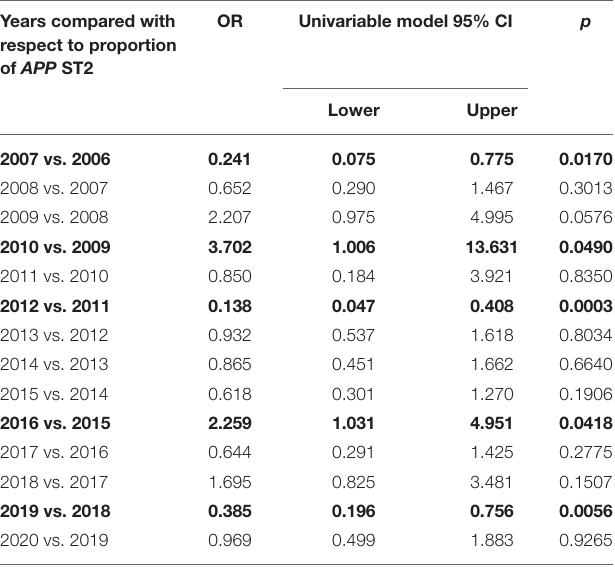
TABLE 2 | Outcome of linear logistic regression model for comparison of proportion of APP s erotype 2 in subsequent years. Years compared with OR Univariable model 95% CI p respect to proportion of APP ST2 Lower Upper